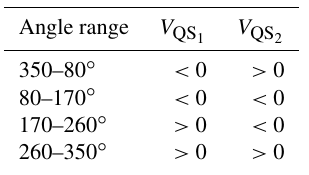
Figure 10. The orientation of VL1’s wind sensor assembly, adapted from Murphy et al. (1990). The degree coordinate axis refers to the Martian planetary directions. The abbreviations TC and WS stand for thermocouple and wind sensor,